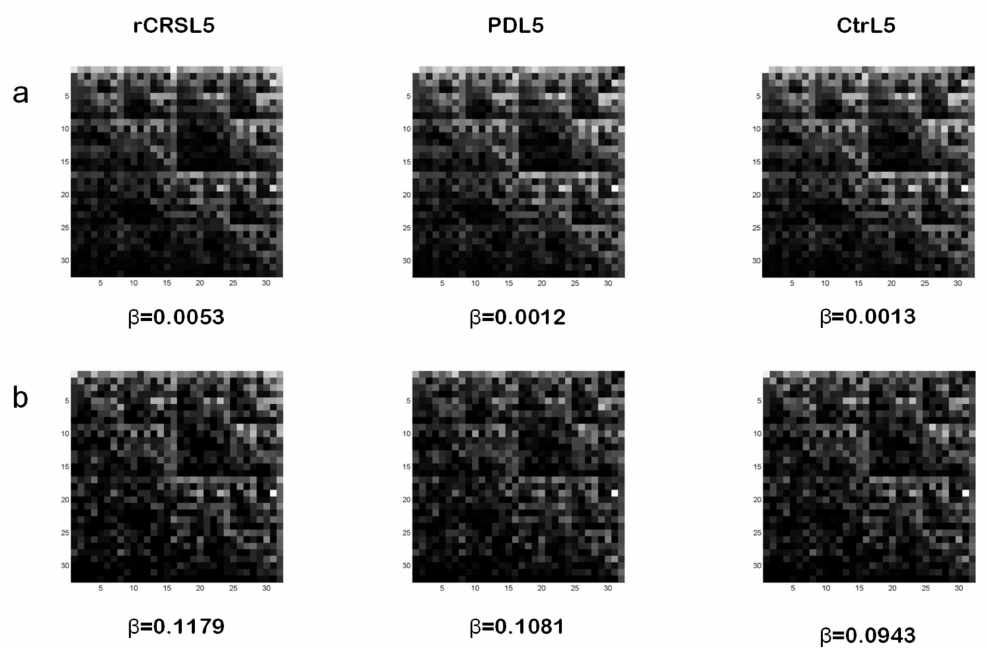
Figure 2. Examples of CGR images of whole mtDNA sequences ( a ) and related GenBank np 5713-9713 frames ( b ) from di ff erentsubjects. Lacunarity parameter β value for CGRmatrices 32x32 (L = 5) generated from mtDNA of rCRS (left), a PD patient (middle), and a control (right) is reported. CGR: Chaos Game Representation; rCRS: revised Cambridge Reference Sequence; PD: Parkinson’s Disease.